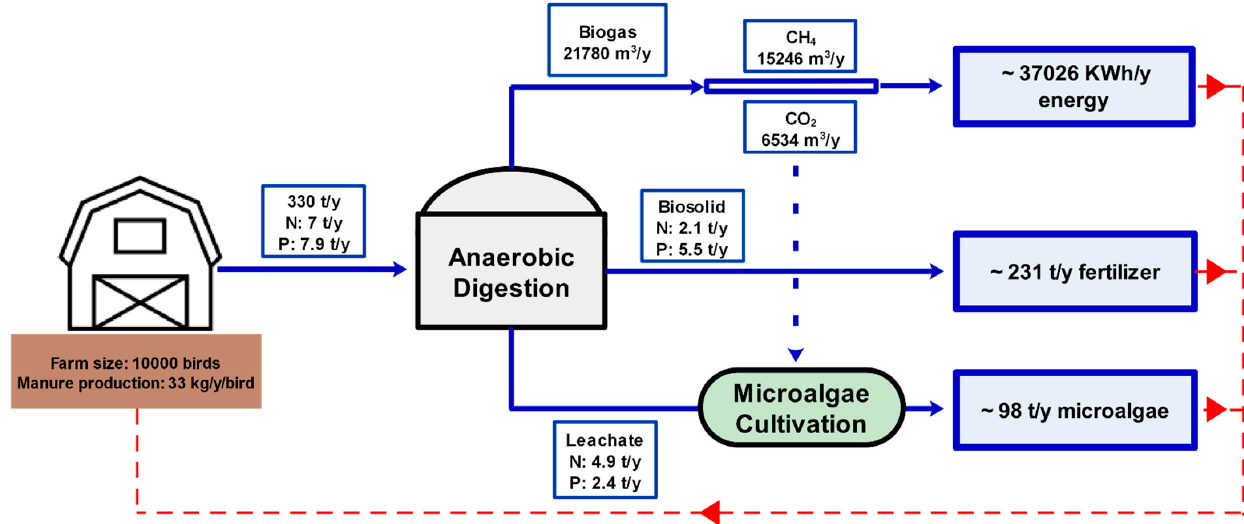
Figure 4. Nutrient mass balance in a closed-loop recycling framework in a poultry farm.